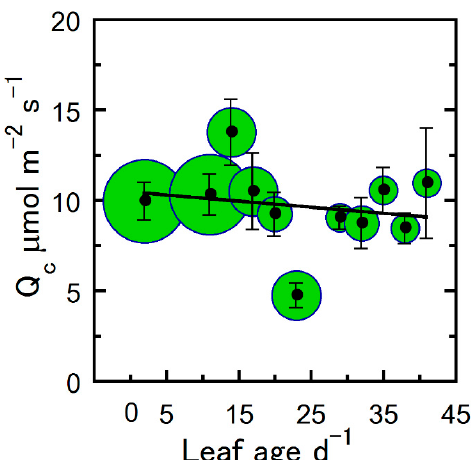
Figure 2. The leaf respiration rate (R d ) of hemp leaves as a function of leaf age. The log base of leaf age and leaf age (primary and secondary x -axis, respectively). Binned averages per three-day collection sequence (means ± SE), where samples were pooled for treatments and crown position, and sample size in bins is indicated by the bubble diameter (n = 3–18 for R d ). Solid line is a linear regression fitted to the entire data set.